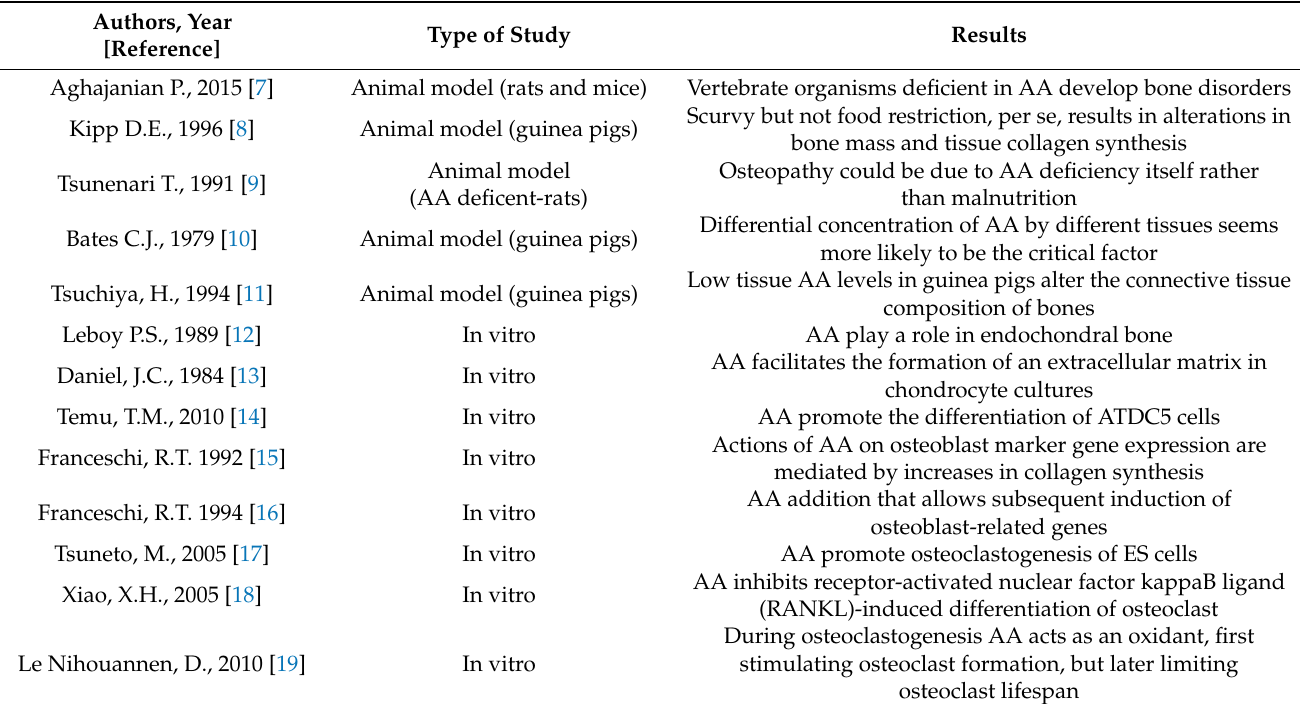
Table 1. Pathophysiological key messages on the role of AA in bone